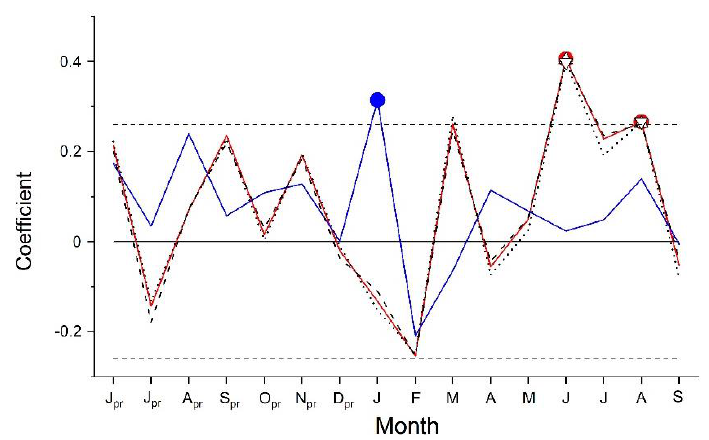
Figure 3. Response function analysis between standardized composite chronology of Alnus alnobetula and monthly precipitation sum (blue line and circle) and monthly mean, maximum and minimum air temperature (red line and filled circle, dashed black line and upward triangle, dotted line and downward triangle, respectively). Horizontal dashed lines represent 95% confidence intervals. Symbols indicate significant relationships at p < 0.05 ( pr = previous year climate variable).